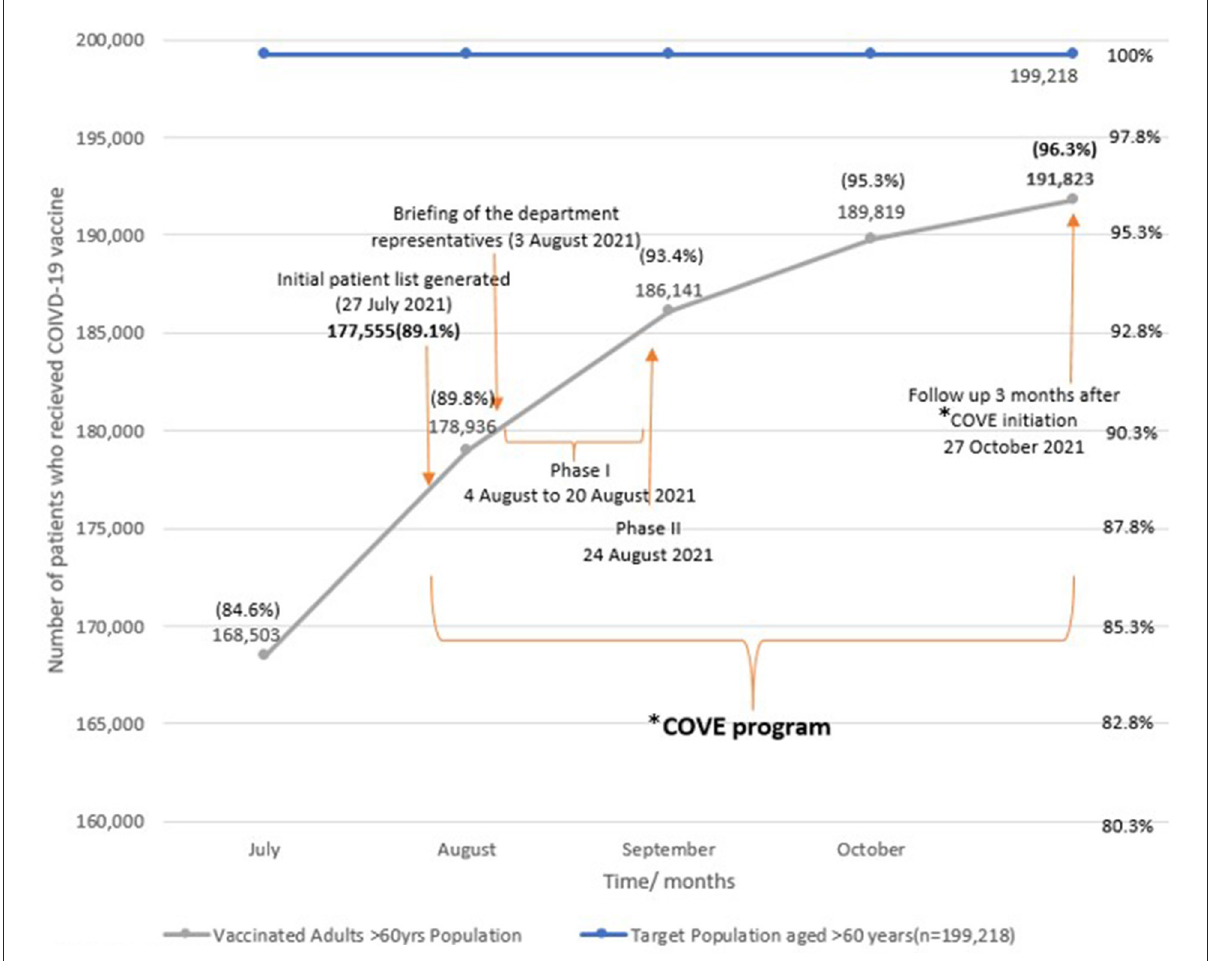
FIGURE2 Timeline of COVE program. * COVE, COVID-19 Vaccination in